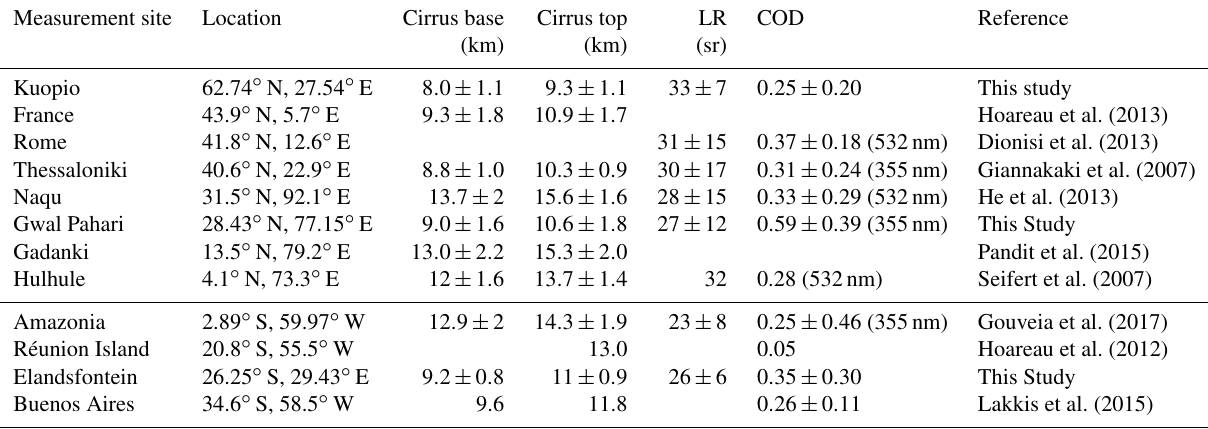
Table 5. Summary of cirrus cloud geometrical and optical properties of ground-based lidar observations reported in literature. Measurement